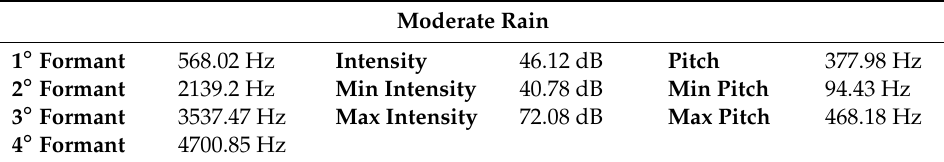
Figure 5. Spectrogram of the audio signal “Moderate rain”. Table 4. Formants, intensity and pitch parameters of “Moderate rain” audio signal.